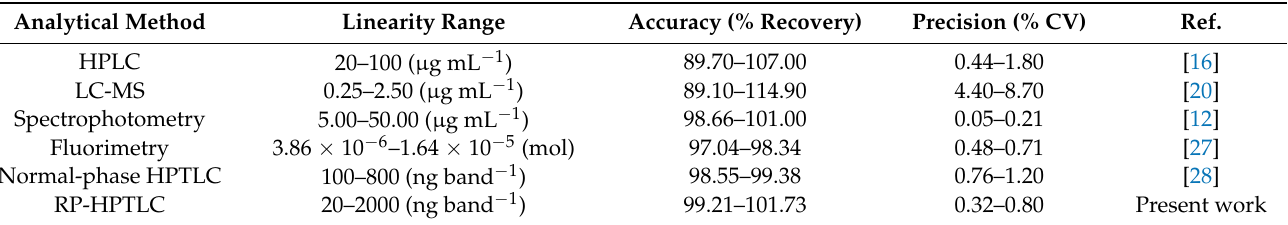
Table 7. Comparative evaluation of the present RP-HPTLC assay with reported analytical assays for the quantitative analysis of